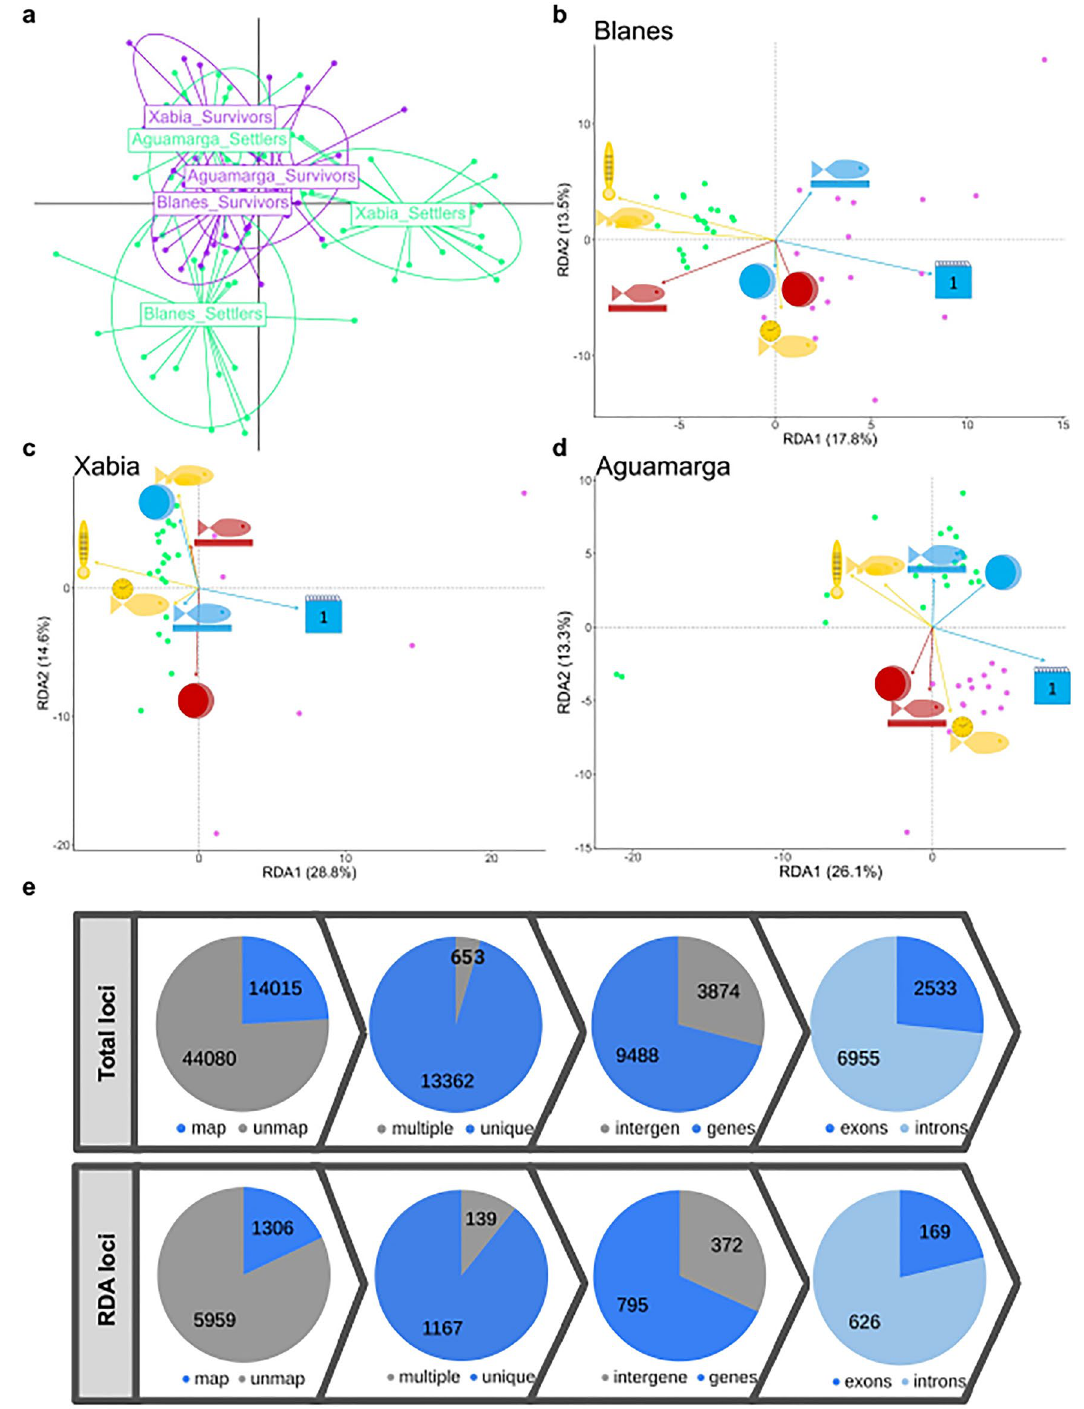
Figure 3. Genomic structure of settlers and survivors and structural distribution of candidate loci associated with phenotypic and environmental variables. ( a ) Discriminant Analysis of Principal Components (DAPC) plot of settlers (green) and survivors (violet) of the three localities based on 58,095 haplotype loci. ( b–d ) Redundancy Analyses (RDA) performed with individually based genotypic, phenotypic and environmental data for each locality based on 85,031 SNPs. Vectors indicate phenotypic and environmental predictors of the two first RDA components, green dots correspond to settlers and violet dots to survivors. Predictor symbols are the same as in Fig. 2. ( b ) Blanes, ( c ) Xabia and ( d ) Aguamarga. ( e ) The distribution of all analysed loci of Diplodus puntazzo loci according to blast searches in the annotated genome of Sparus aurata (top) and the RDA candidate loci (bottom): from left to right number and frequency of mapped and unmapped loci, unique and multiple loci, loci in genic and intergenic regions, and loci in exons and